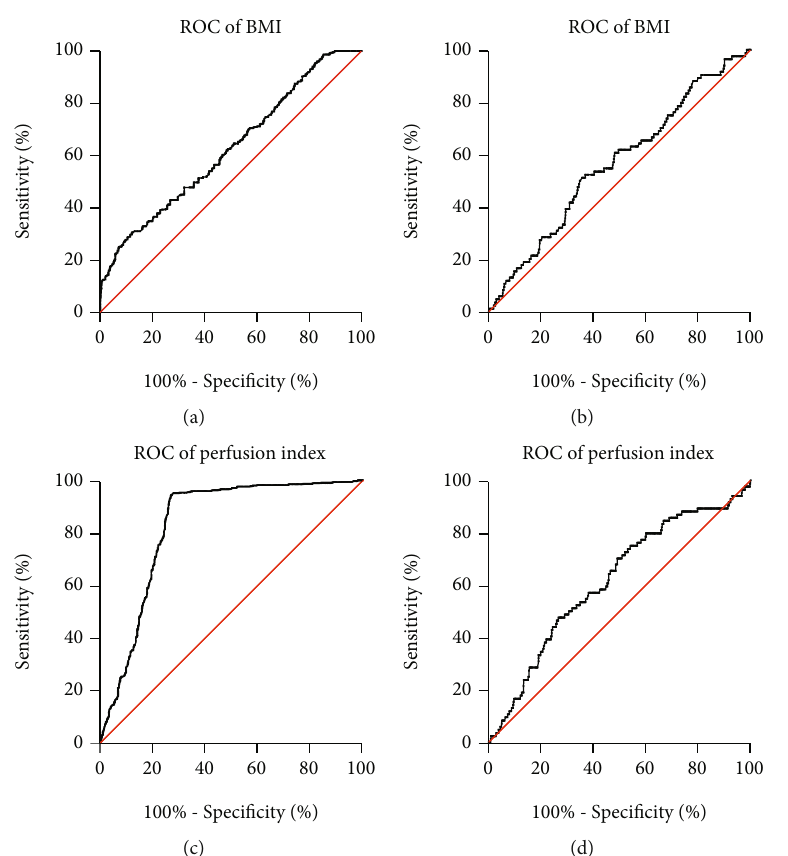
Figure 2: ROC of BMI and perfusion index for the diagnosis of intraoperative hypotension and poor prognosis of neonates in cesarean section women. (a), ROC for BMI diagnosis of intraoperative hypotension in cesarean section women. (b), BMI diagnosis of ROC with poor neonatal prognosis. (c), ROC of perfusion index for diagnosis of intraoperative hypotension in cesarean section. (d), Perfusion index in diagnosis of ROC with poor neonatal